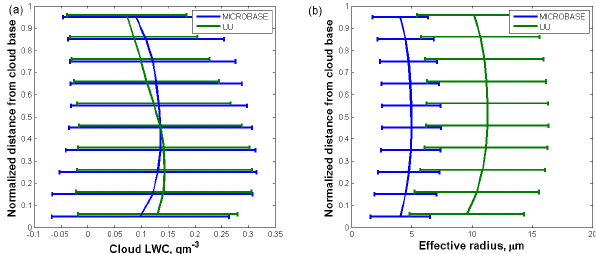
Fig. 5. Nine-year average MICROBASE and UU cloud LWC and r e as a function of normalized distance from cloud base. Horizontal error bars represent the corresponding standard deviations. The UU profiles are shifted upward by 0.01 normalized distance for a better illustration.